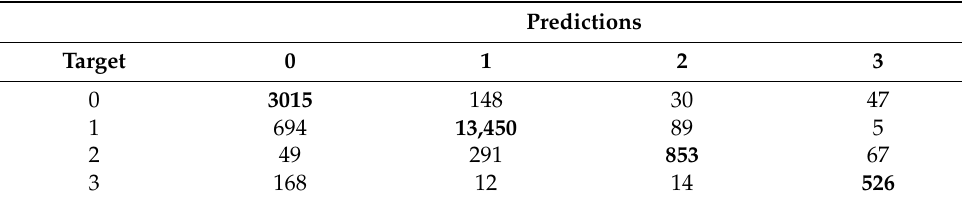
Table 4. Confusion matrix for the artificial neural network-based model.